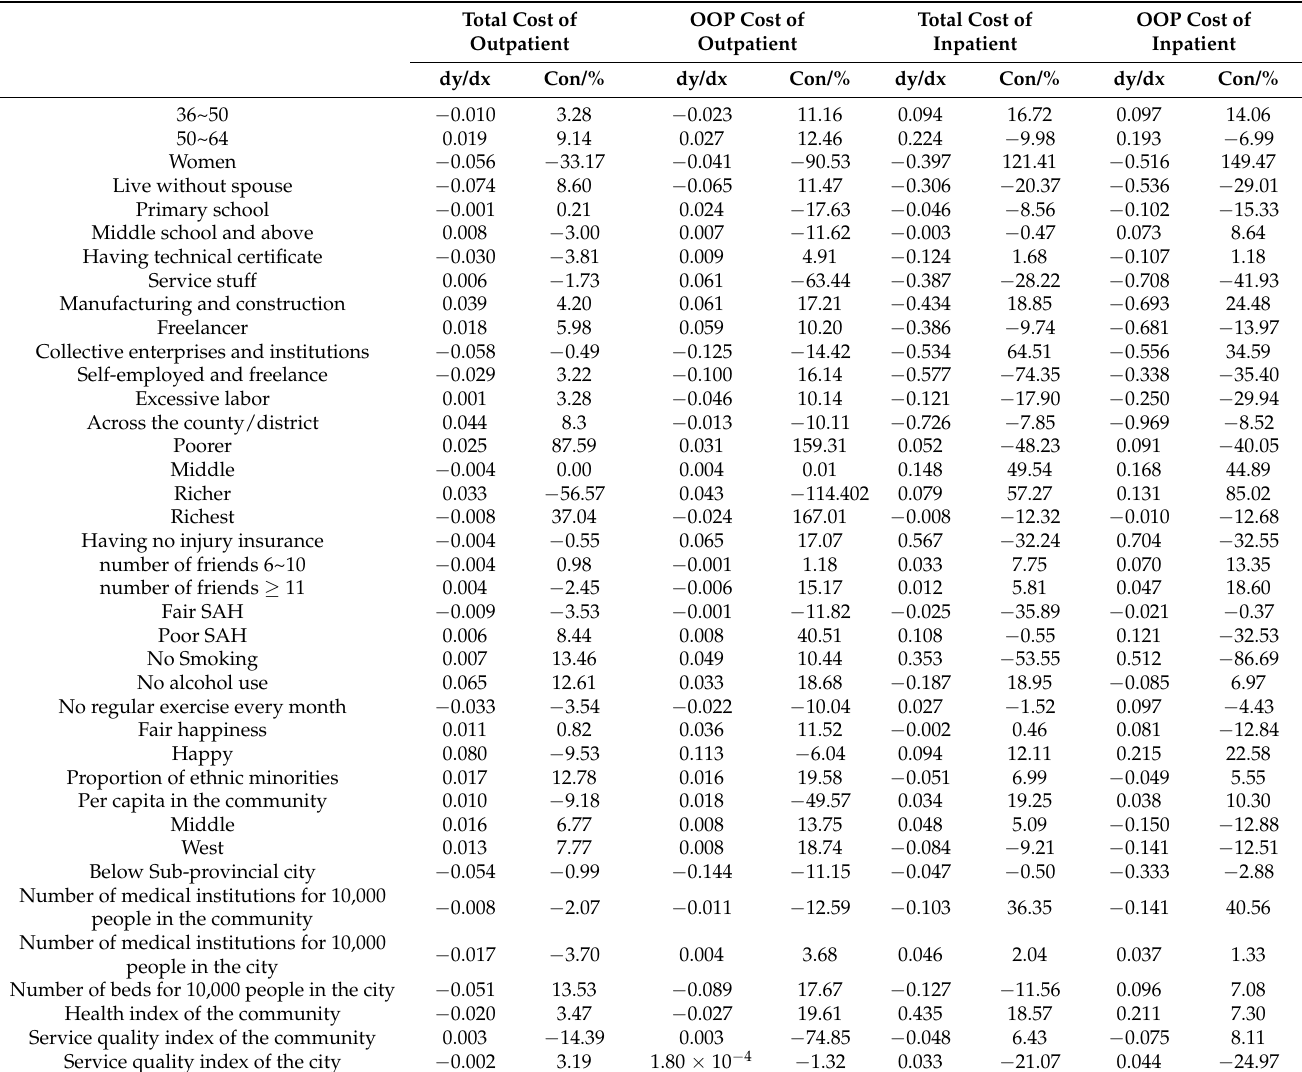
Table 8. Concentration index decomposition of the total cost and OOP of two-week outpatient and inpatient among rural migrant workers with